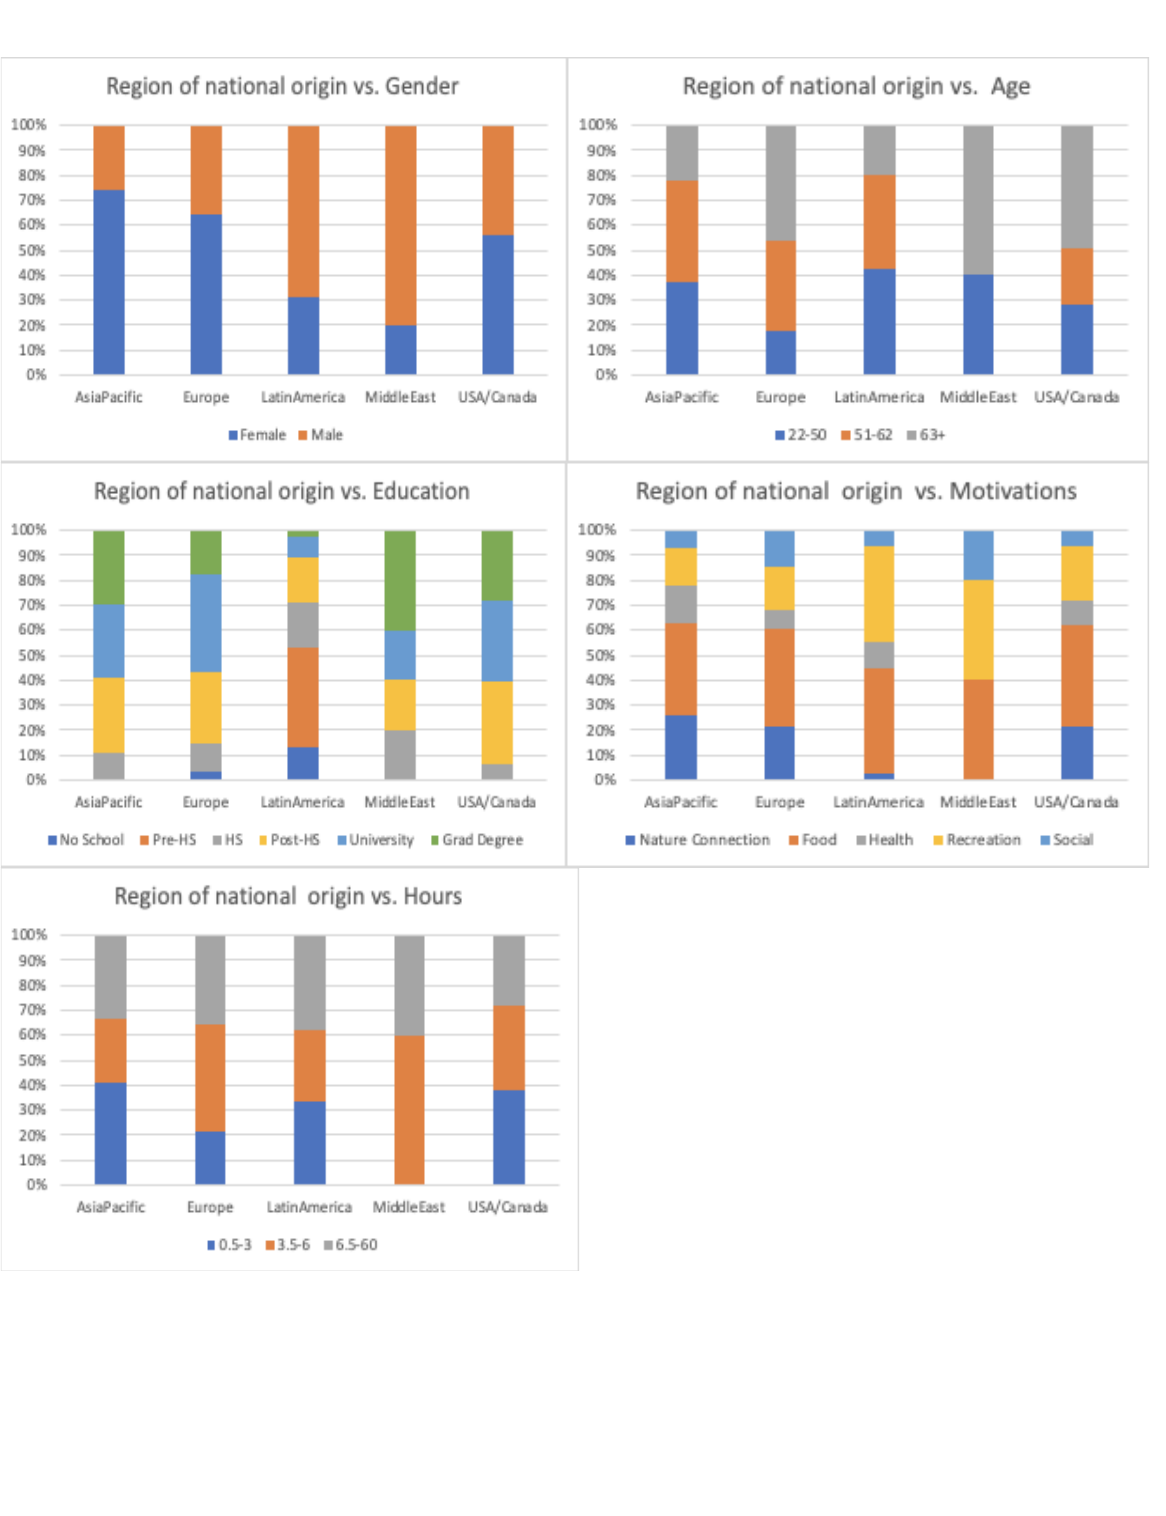
Figure A2.4. Relationships between region of national origin and gender, age, education, motivations for gardening, and hours spent